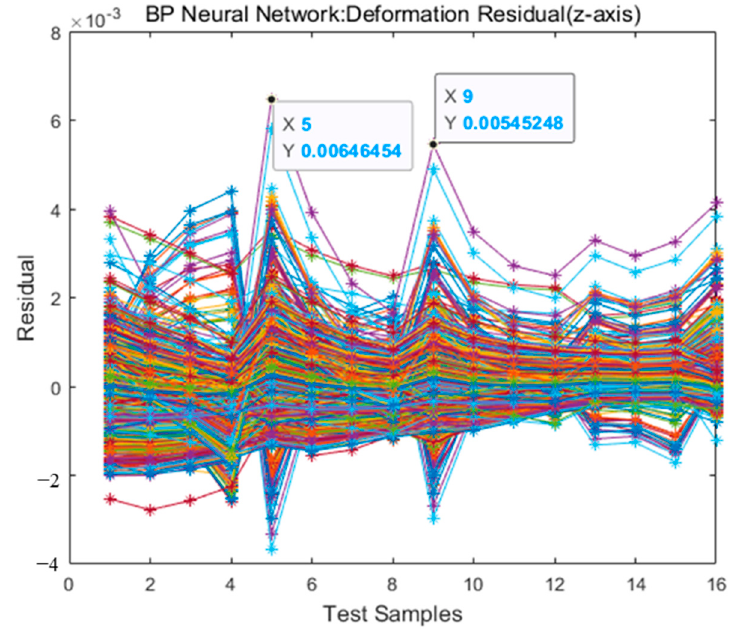
Figure 6. Residual between predictive value and true value.